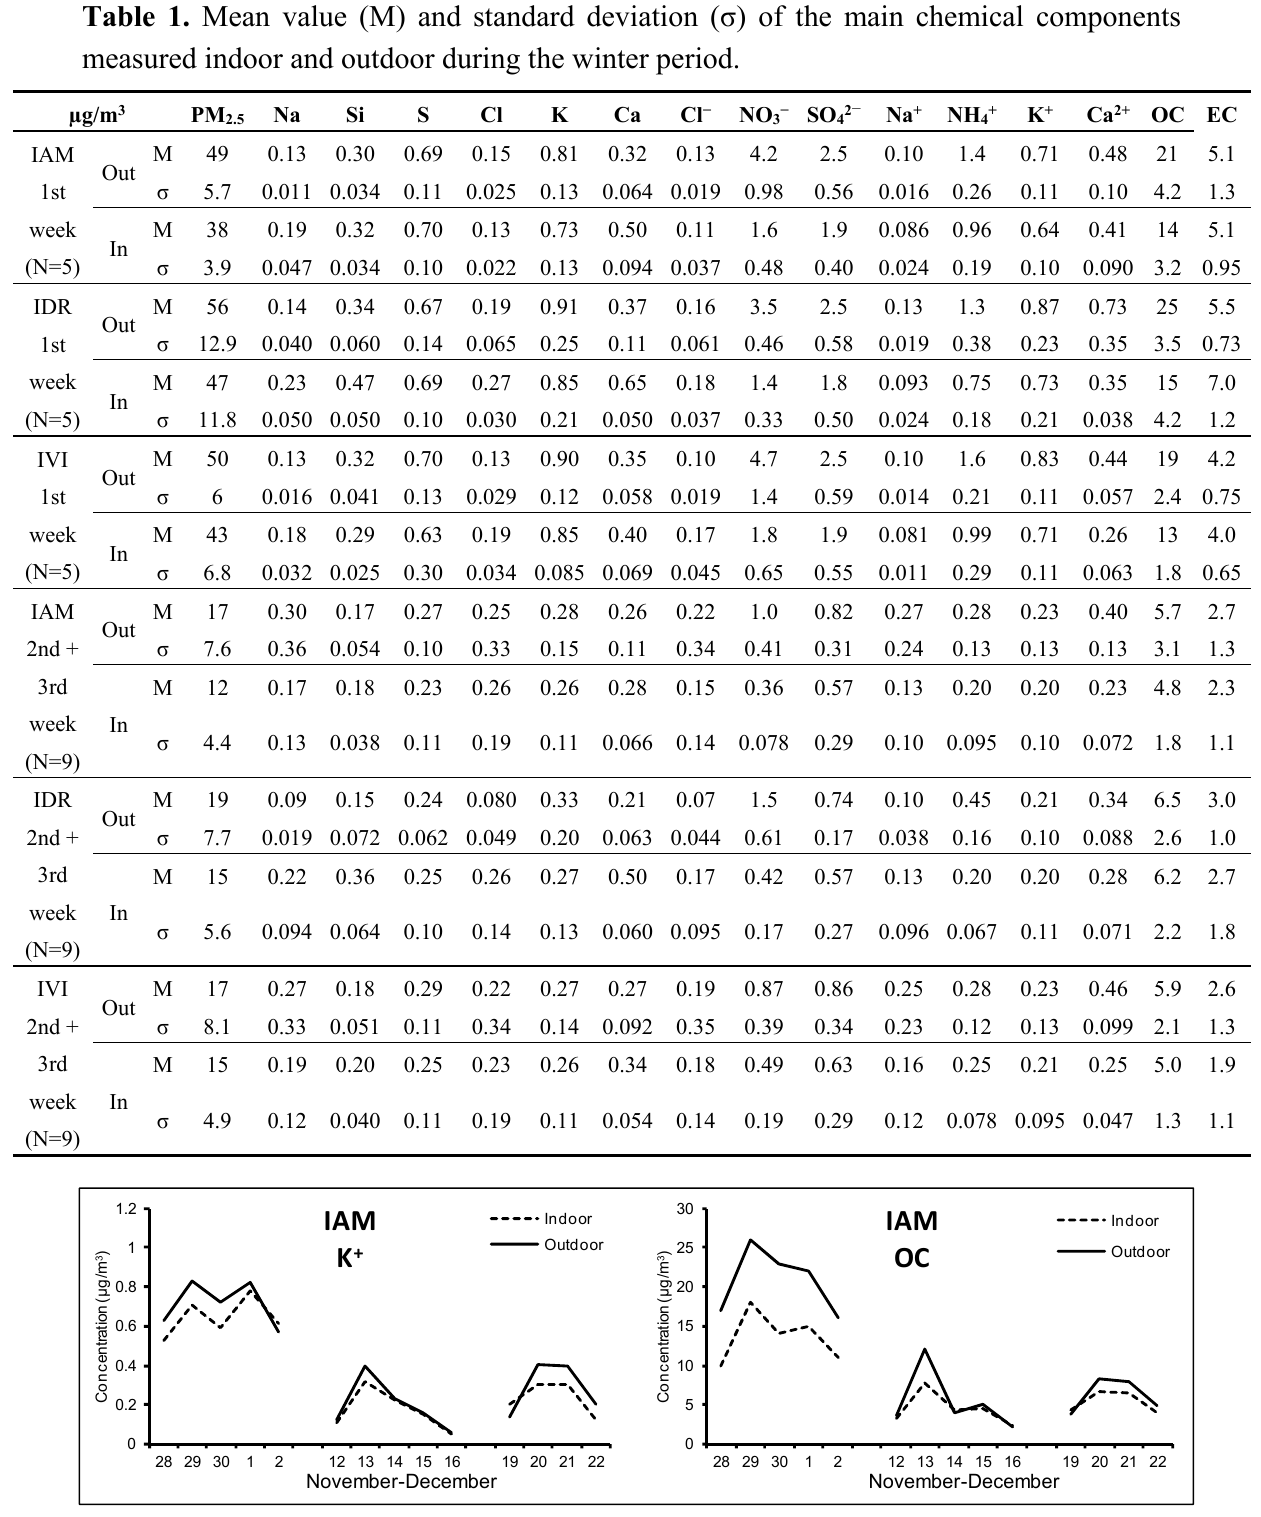
Figure 4. Outdoor and indoor time pattern of K + and OC at IAM site during the winter